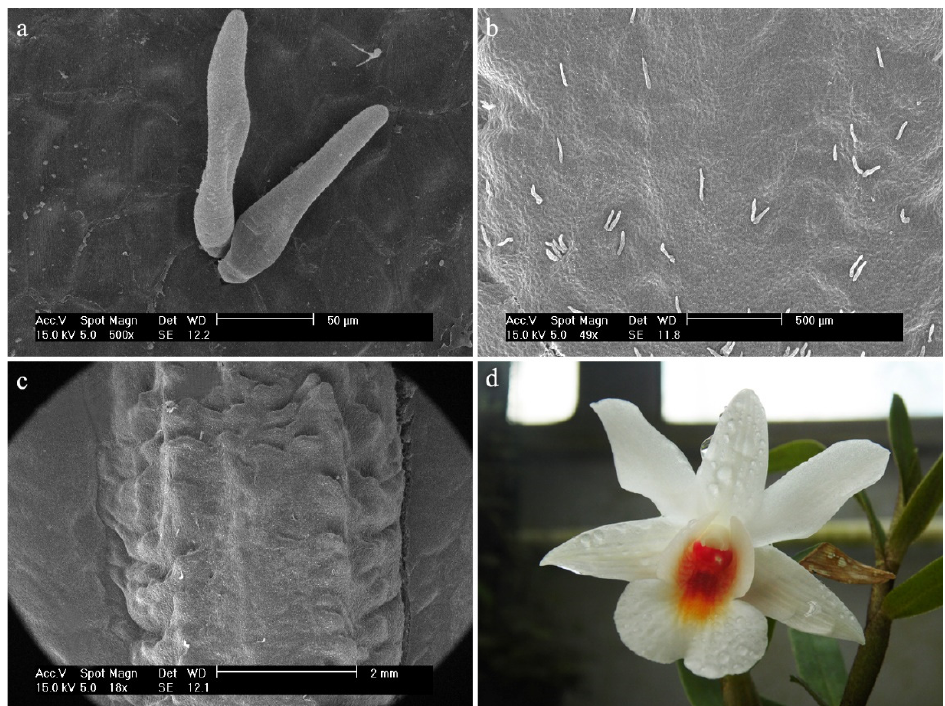
Figure 14. Dendrobium christyanum Rchb.f . Trichomes: ( a , b ) of the hypochile part of the labellum; ( c ) of the mesochile part of the labellum; ( d ) flower (photo by Monika Lipi ń ska).